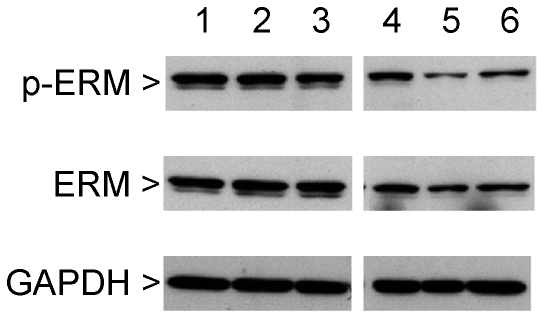
Protein expression and phosphorylation of the putative LRRK2 substrate proteins ezrin, radixin, and moesin (ERM).Immunoreactive bands are reduced in LRRK2+/− ES cell-derived neurons (lane 4–6) compared to wildtype cultures (lane 1–3). Levels of glyceraldehyde 3-phosphate dehydrogenase (GAPDH) are shown as gel loading controls. Three replicate cultures per genotype were analysed. For densitometric quantification see Results section.